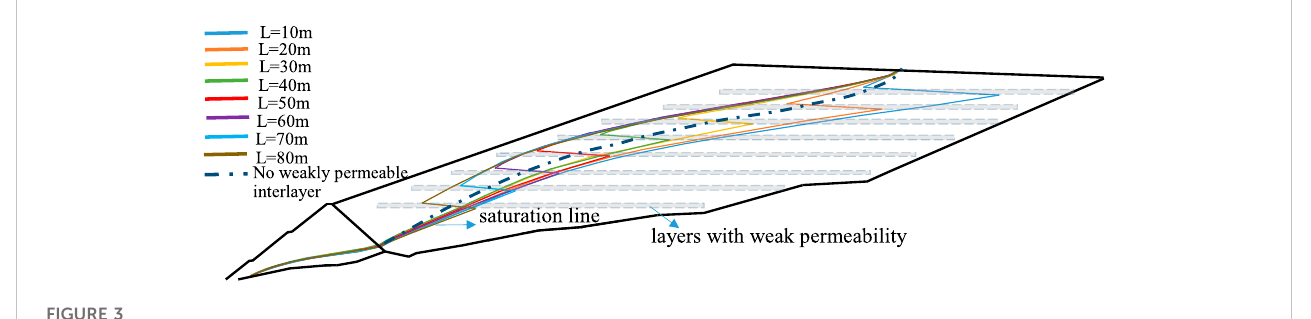
FIGURE 3 Diagram of in fi ltration line with the position of weakly permeable interlayer.